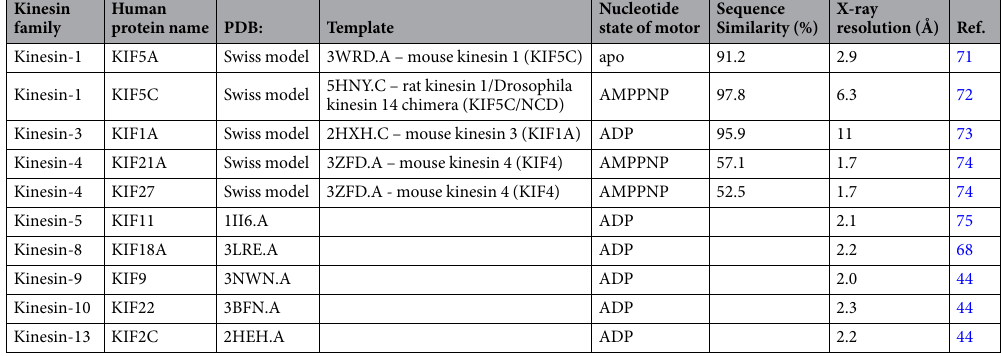
Table 1. Details of the 10 wild type kinesin structures